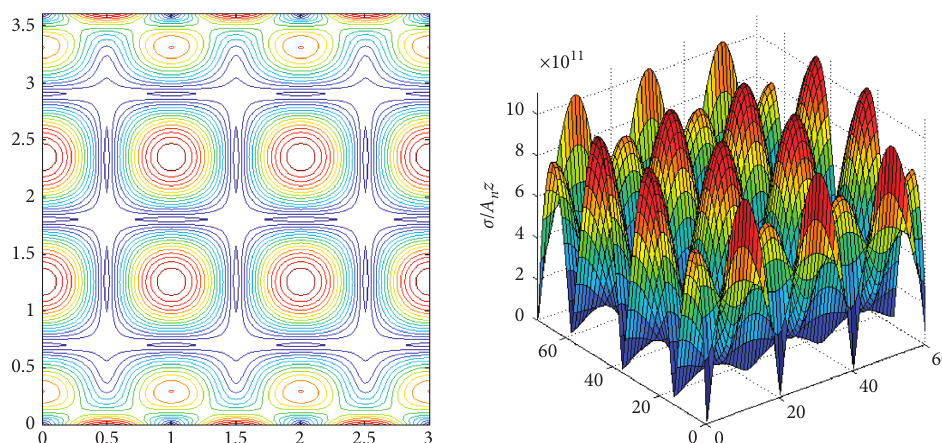
Figure 5: The maximum shear of the 10 th order mode (S-C-S-C).